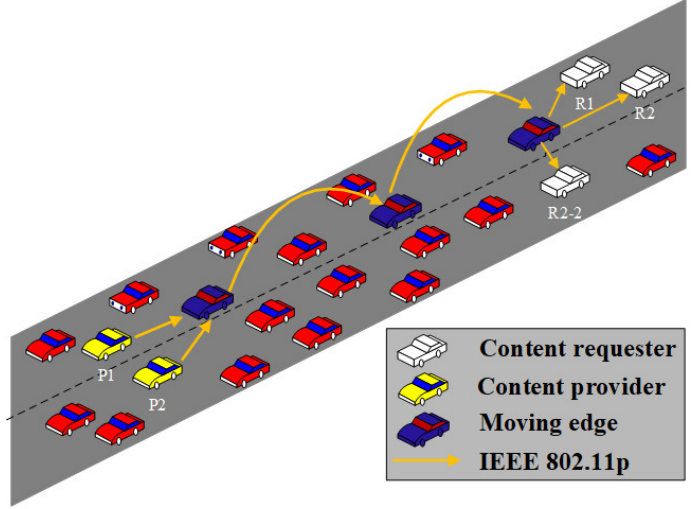
Figure 1. Edge-based